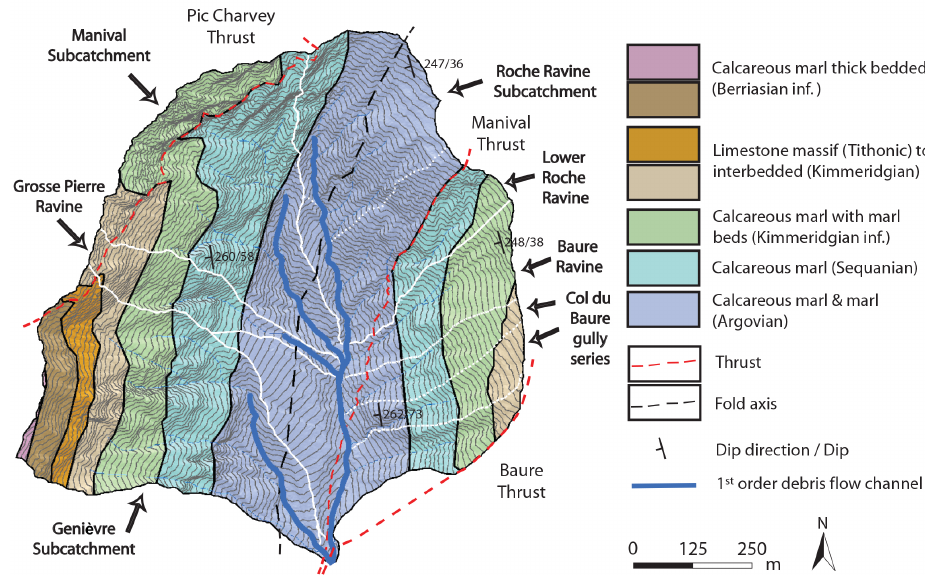
Figure 2. Geological map of the catchment headwater (production zone) after Gidon (1991) and location of first-order debris flow channels (thick blue line) and their respective watersheds (white lines). For the ease of analysis, the Roche Ravine and Col du Baure subcatchments in the east side were further subdivided according to their gully complex (dotted white